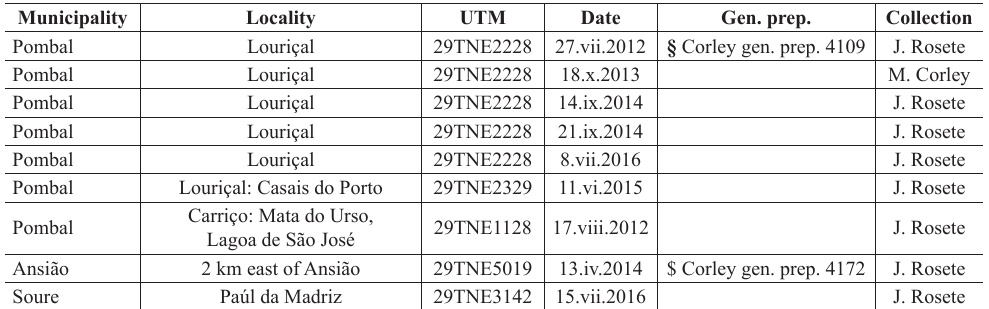
Table 1. Borkhausenia crimnodes specimens captured in Portugal. For each we list the Municipality, locality, the UTM coordinates, date of collection, genitalia preparation code when applicable and collection where the specimens are